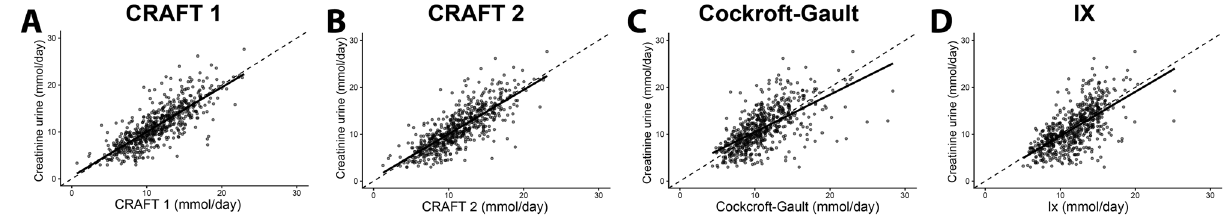
Figure 3. Plots comparing CRAFT 1 ( A ), CRAFT 2 ( B ), Cockcroft-Gault ( C ), and Ix equation ( D ) to creatinine excretion in the validation dataset. Solid regression lines in dot plots are calculated with ordinary least squares regression. The dashed line is the line of